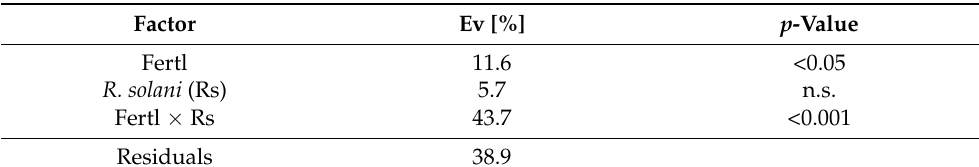
Table 2. Effect of long-term mineral (HU-min) and organic (HU-org) fertilization strategy (Fertl) and the presence of the pathogen Rhizoctonia solani AG1-IB on 18 defense-related genes expressed in lettuce leaves (cv. Tizian). Results based on PERMANOVA analysis of ∆ Ct values with Bray–Curtis distances (10,000 permutations). Ev—explained variance.